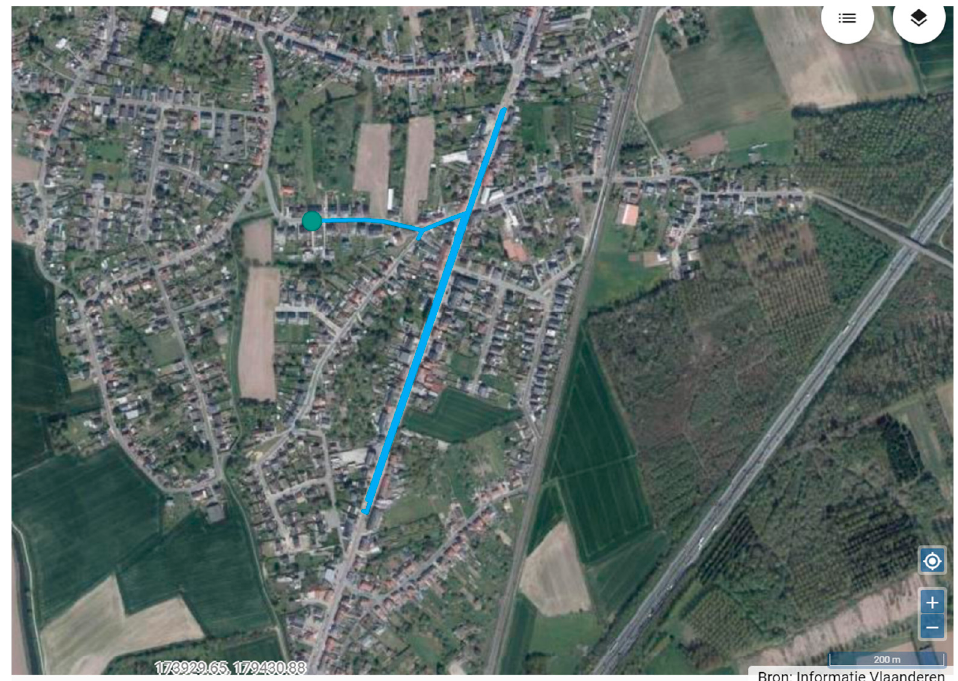
Figure A2. Overview of the catchment in Wilsele. The green dot shows the inspection well where the samples were taken. The blue area is connected to the inspection